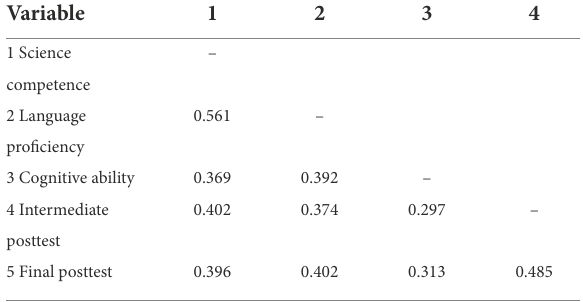
TABLE 3 Intercorrelations of student variables.